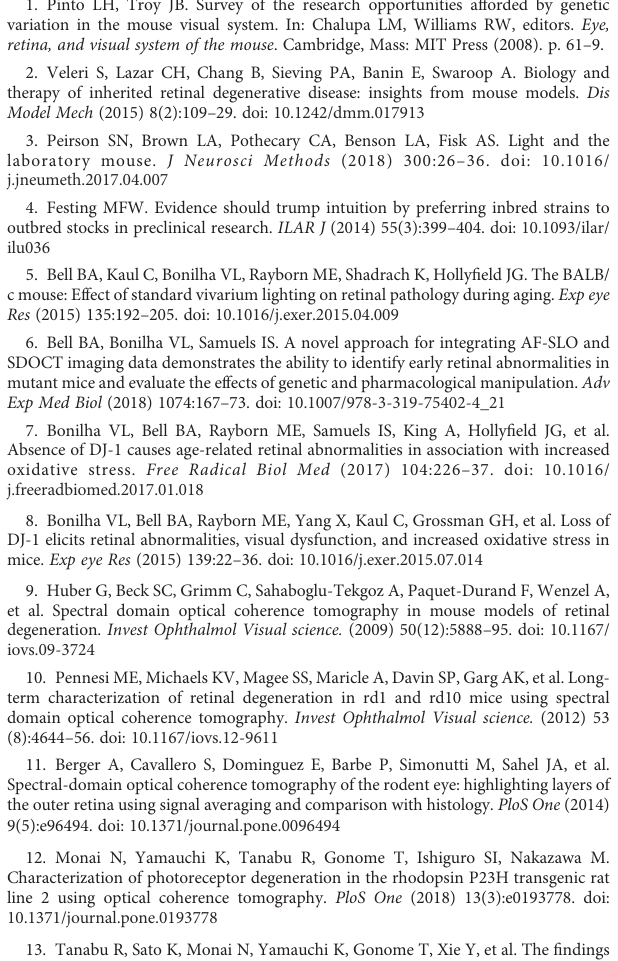
SUPPLEMENTARY FIGURE 2 Illustration of Analysis#5 measurements for extracting the outer segment signal amplitude ( D OS). SUPPLEMENTARY FIGURE 3 Illustration of Analysis#6 measurements for extracting the inner segment signal amplitude ( D IS). SUPPLEMENTARY FIGURE 4 Illustration of Analysis#7 measurements for extracting and parsing out individual lamina from the photoreceptor layer (PL) and adjacent retinal pigmented epithelium-Bruch ’ s membrane complex (RPEBM). SUPPLEMENTARY FIGURE 5 Scatter plot of the OS signal slope vs DLE-BLE-DLE challenge for B6-albino and B6 mice. Each dot represents the average slope from the 4 regional quadrants. Group averages shown as Mean+/-95% CI. SUPPLEMENTARY FIGURE 6 Spearman ’ s Correlation and Predictive Power Score (PPS) Matrices for BALB/ c, B6-albino, and B6 mouse strains. SUPPLEMENTARY FIGURE 7 BLE-induced SD-OCT re fl ectivity changes in the proximal photoreceptor outer segment of an albino vs. pigmented